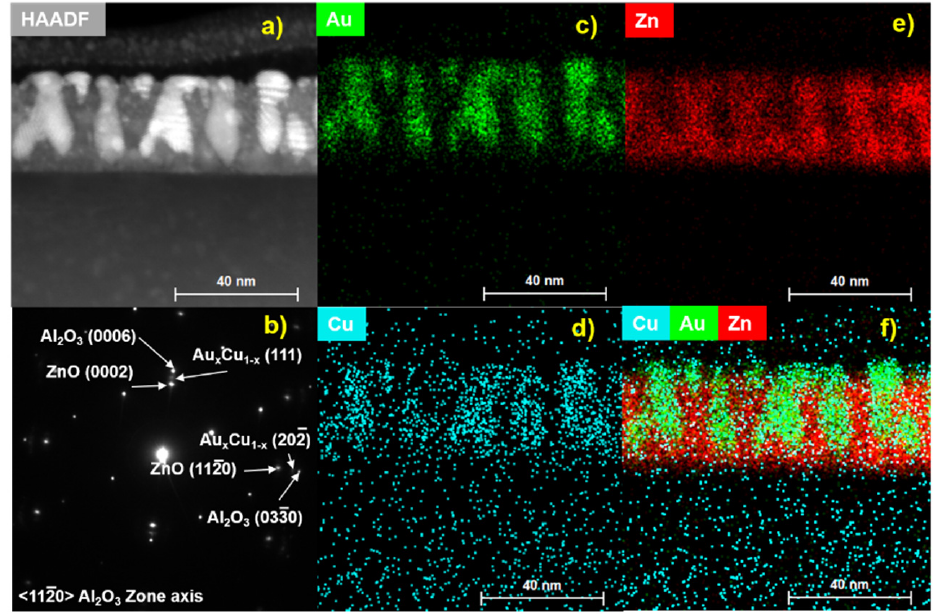
Figure 2. Cross-section STEM image of ZnO-AuxCu1-x. ( a ) HAADF cross-section image, ( b ) cross- section SAED pattern, ( c ) EDS Au map, ( d ) EDS Cu-map, ( e ) EDS Zn-map, ( f ) combined EDS-map.